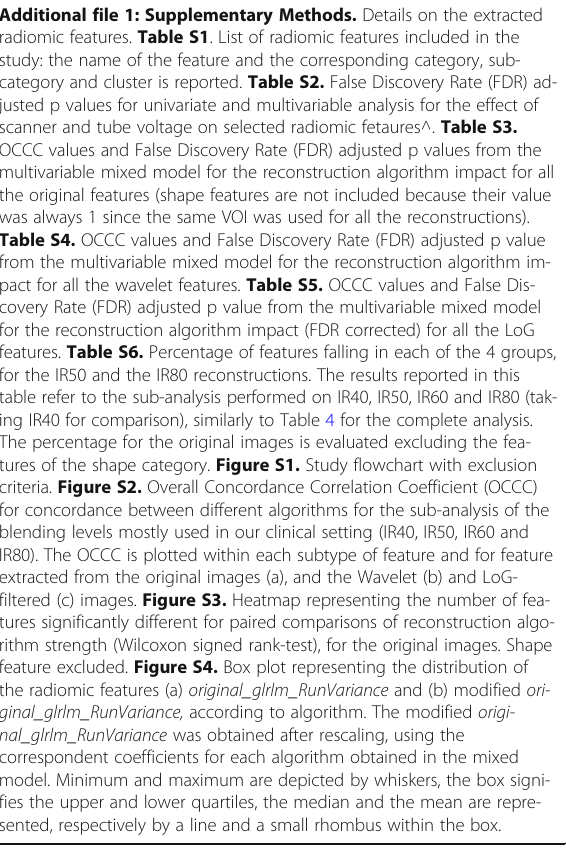
study: the name of the feature and the corresponding category, sub- category and cluster is reported. Table S2. False Discovery Rate (FDR) ad- justed p values for univariate and multivariable analysis for the effect of scanner and tube voltage on selected radiomic fetaures^. Table S3. OCCC values and False Discovery Rate (FDR) adjusted p values from the multivariable mixed model for the reconstruction algorithm impact for all the original features (shape features are not included because their value was always 1 since the same VOI was used for all the reconstructions). Table S4. OCCC values and False Discovery Rate (FDR) adjusted p value from the multivariable mixed model for the reconstruction algorithm im- pact for all the wavelet features. Table S5. OCCC values and False Dis- covery Rate (FDR) adjusted p value from the multivariable mixed model for the reconstruction algorithm impact (FDR corrected) for all the LoG features. Table S6. Percentage of features falling in each of the 4 groups, for the IR50 and the IR80 reconstructions. The results reported in this table refer to the sub-analysis performed on IR40, IR50, IR60 and IR80 (tak- ing IR40 for comparison), similarly to Table 4 for the complete analysis. The percentage for the original images is evaluated excluding the fea- tures of the shape category. Figure S1. Study flowchart with exclusion criteria. Figure S2. Overall Concordance Correlation Coefficient (OCCC) for concordance between different algorithms for the sub-analysis of the blending levels mostly used in our clinical setting (IR40, IR50, IR60 and IR80). The OCCC is plotted within each subtype of feature and for feature extracted from the original images (a), and the Wavelet (b) and LoG- filtered (c) images. Figure S3. Heatmap representing the number of fea- tures significantly different for paired comparisons of reconstruction algo- rithm strength (Wilcoxon signed rank-test), for the original images. Shape feature excluded. Figure S4. Box plot representing the distribution of the radiomic features (a) original_glrlm_RunVariance and (b) modified ori- ginal_glrlm_RunVariance, according to algorithm. The modified origi- nal_glrlm_RunVariance was obtained after rescaling, using the correspondent coefficients for each algorithm obtained in the mixed model. Minimum and maximum are depicted by whiskers, the box signi- fies the upper and lower quartiles, the median and the mean are repre- sented, respectively by a line and a small rhombus within the